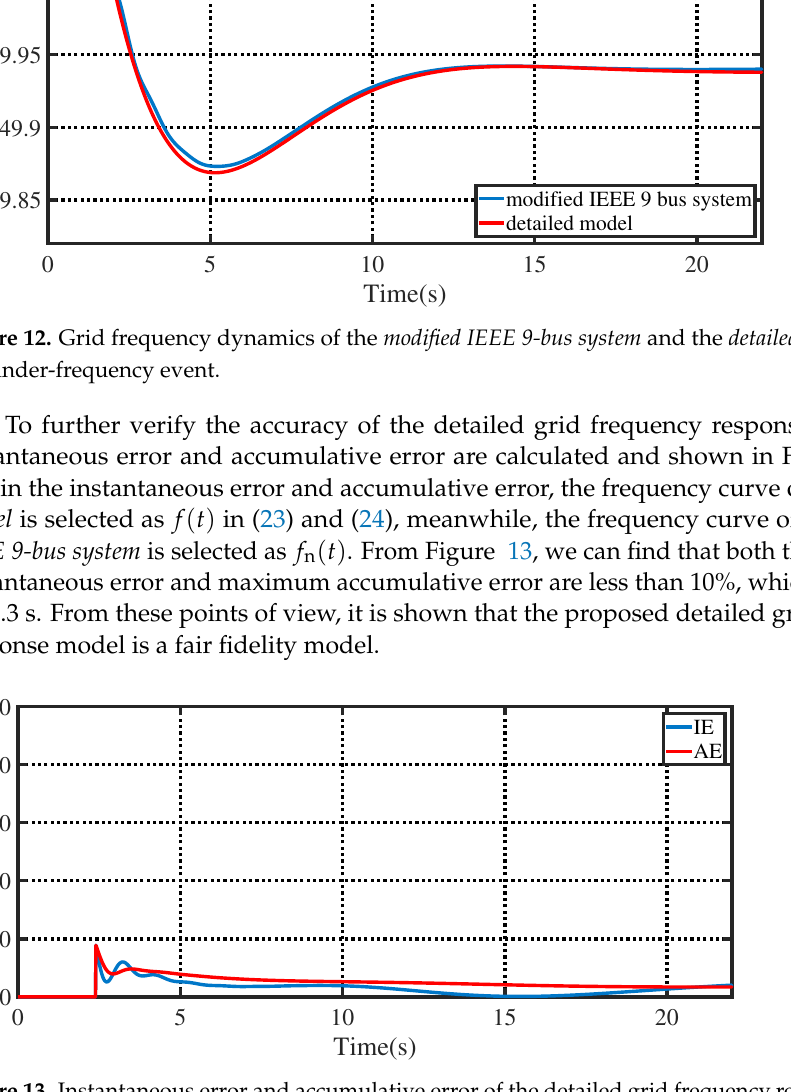
Figure 13. Instantaneous error and accumulative error of the detailed grid frequency response